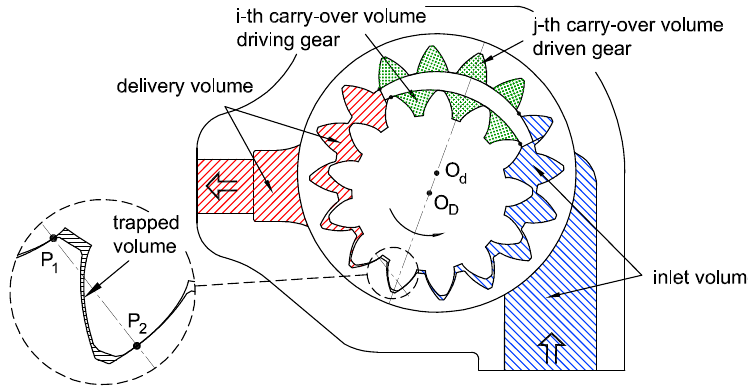
Figure 5. Definition of the control volumes with the MC method for a crescent pump.